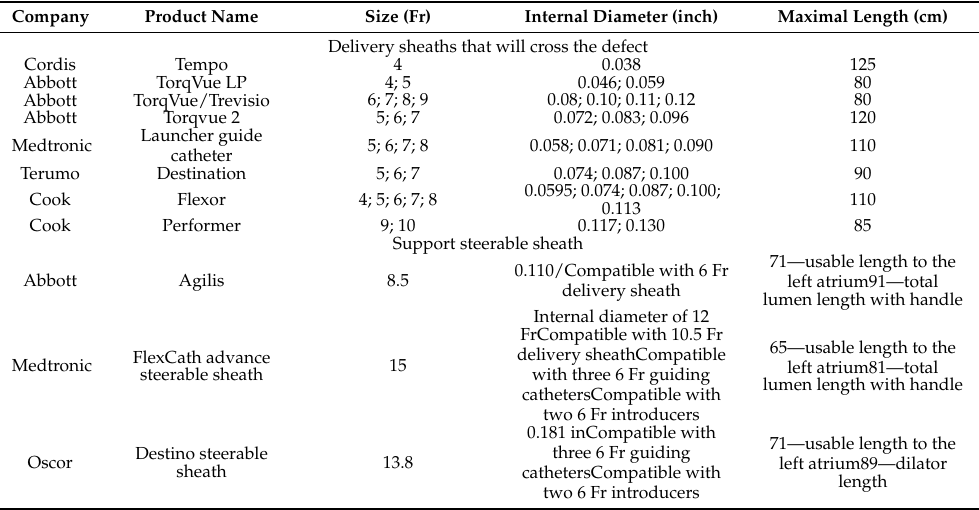
Table 5. The list of delivery sheaths and support steerable sheaths that were used for percutaneous paravalvular leak closure